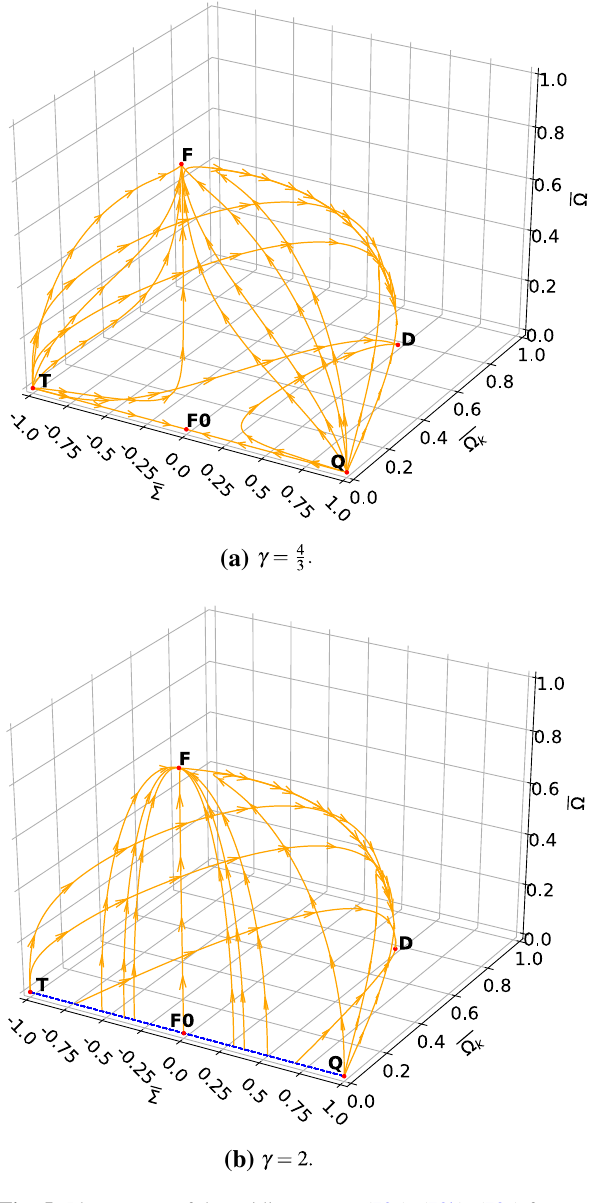
Fig. 5 Phase space of the guiding system (78a), (78b), (78c) for γ = , 2 4 3